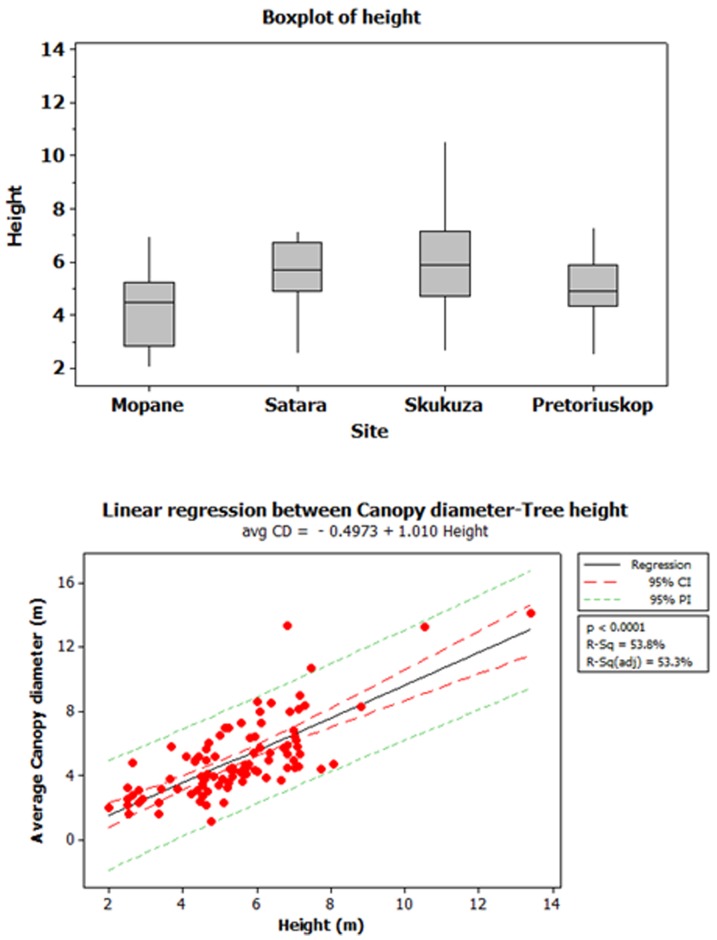
Box and whisker box plots of tree heights in the different study sites (a).The solid line is the median, and the boxes are defined by the upper and lower quartile (25th and 75th percentiles). The whiskers extend up to 1.5 times the inter-quartile range of the data. The figure indicates that distribution of tree heights was not uneven between study sites. Relationship between average canopy diameter (m) and tree height (m) across all sampled trees (b). Average canopy diameter is the mean of canopy diameters measured along two perpendicular axes. Regression results indicate a tight relationship between canopy diameter and tree height, with taller trees having proportionally larger canopies regardless of species identities (adjusted R2 = 53.8%, p<0.0001. CI: 95% confidence interval, PI: 95% predicted interval).